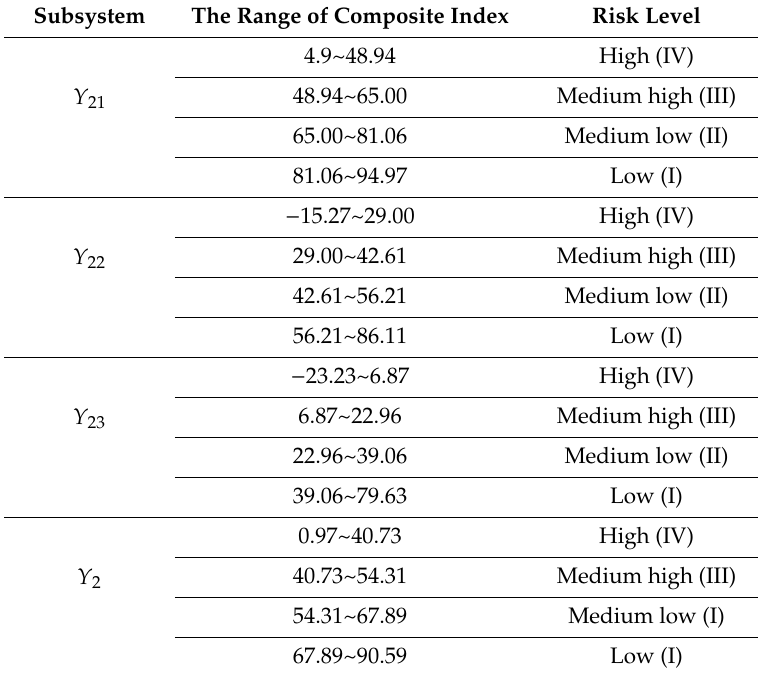
Table 12. Assessment